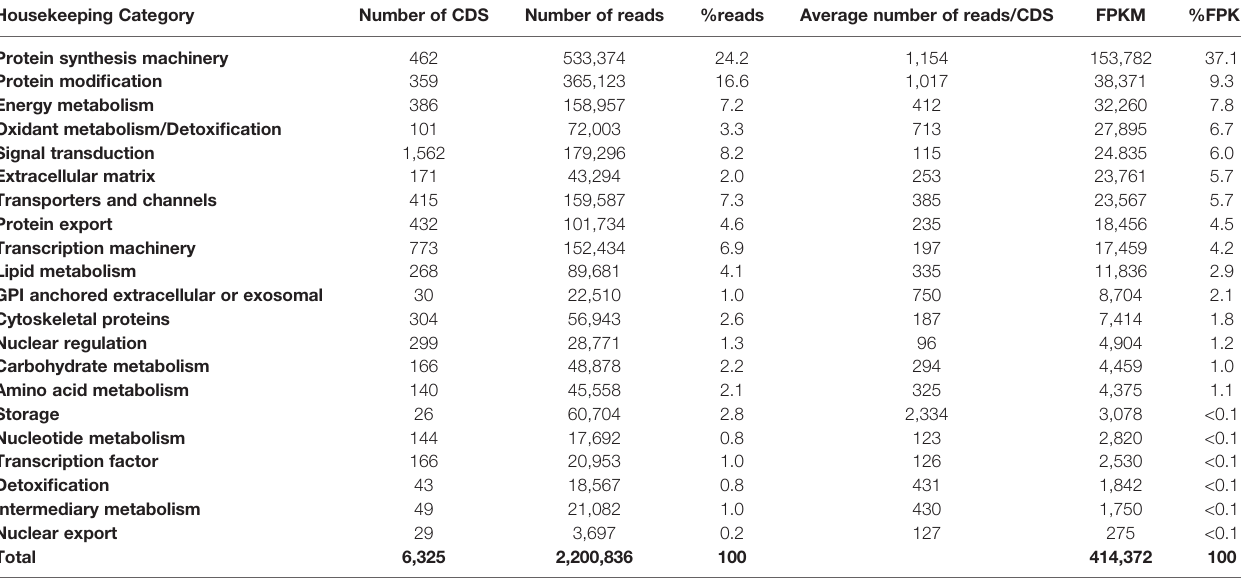
TABLE 2 | Functional classi fi cation and expression levels of the CDS attributed to the Housekeeping category extracted from Triatoma sordida sialotranscriptome. Housekeeping Category Protein synthesis machinery